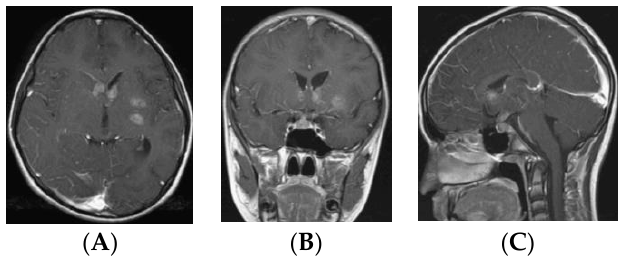
Figure 10. A 10-year-old boy with a month history of progressive right sided hemiparesis and headaches. On admission he was noted panhypopituitarism including DI. Post-contrast MR, axial ( A ), coronal ( B ), and sagittal ( C ) images showing para-ependymal enhancements with Type III suprasellar